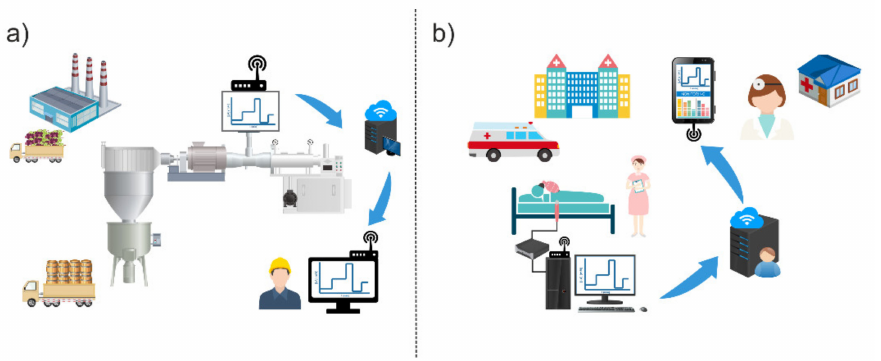
Figure 1. Scheme of relevant high-value situations for real and continuous lactate monitoring, ( a ) wine production and ( b ) intensive care units